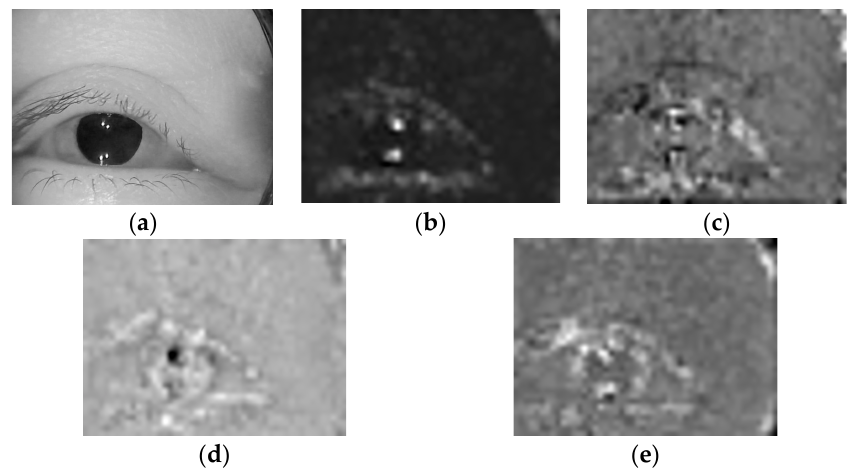
Figure 22. Original image and intermediate results. ( a ) Original image. ( b ) Proposed method. ( c ) Lim’s method. ( d ) Lu’s method. ( e ) Zhang’s method.